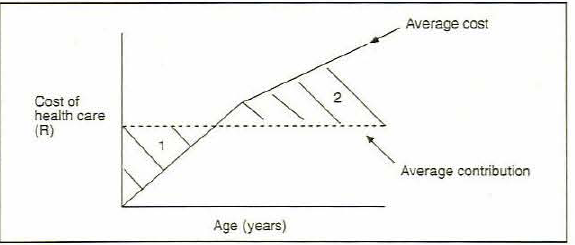
Fig. 2. Health core costs byage of member (with HIV/AIOSj. 1 ~ money received (by means of the average contribution) and not paid out in health care claims; 2 = money reql.:ired (over and above the overage contribution) to pay health care